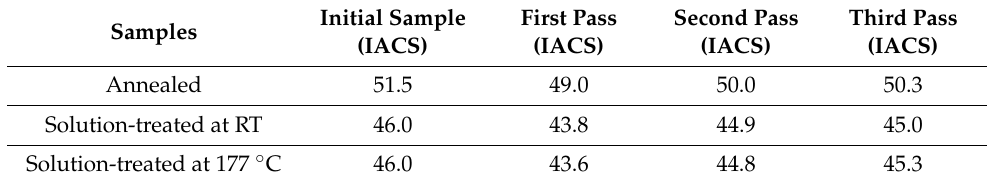
Table 2. Electrical conductivity measurement results (annealed and solution-treated samples of